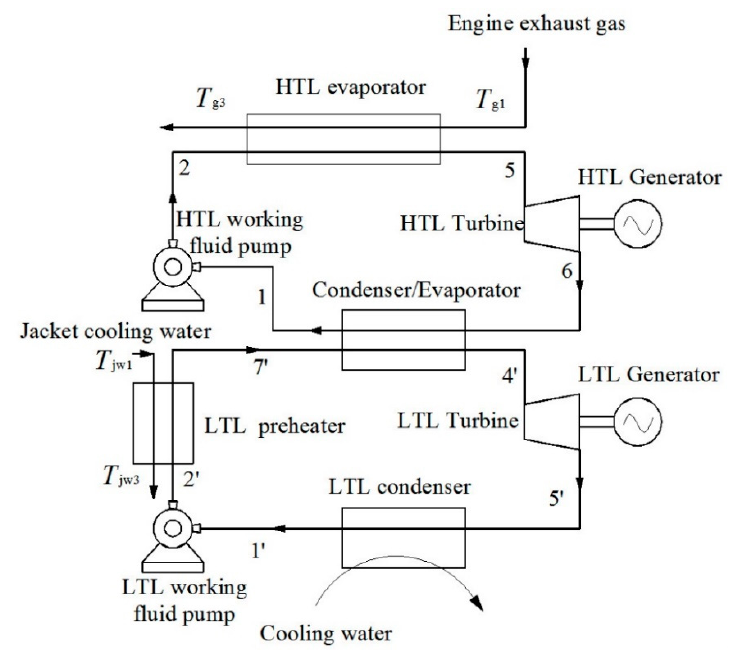
Figure 1. Schematic of the studied dual-loop organic Rankine cycle (DORC) system.